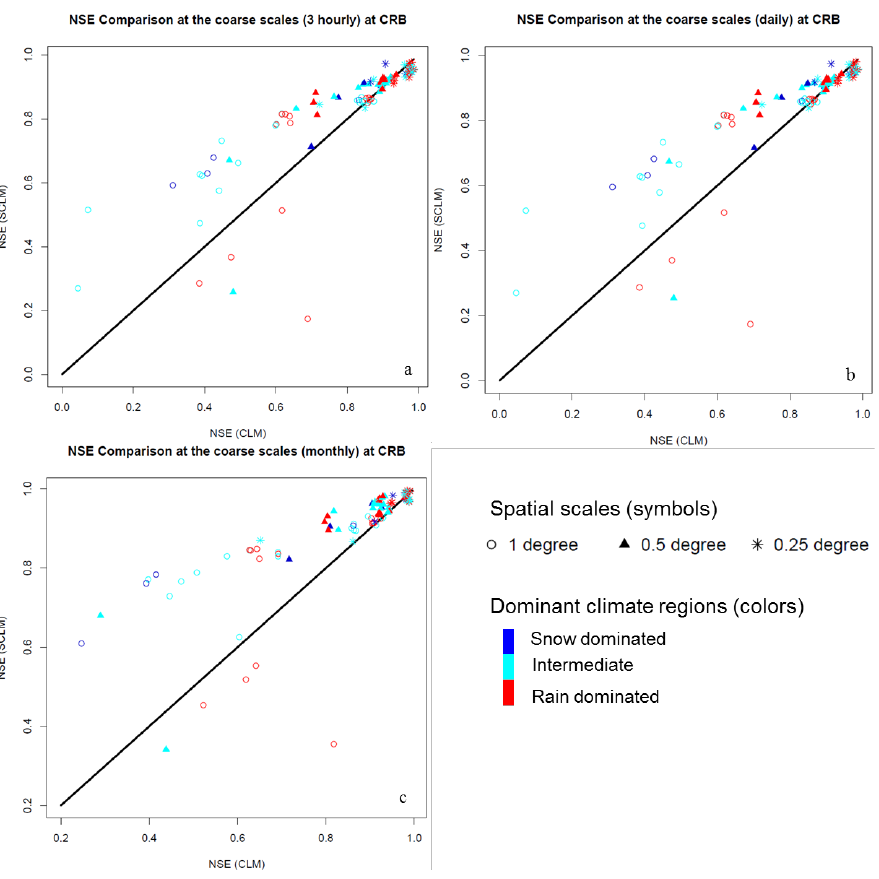
Figure 9. Scalability comparison using a NSE of streamflow at 3-hourly (a) , daily (b) and monthly (c) calculated between each coarse scale and the corresponding fine scale in each modeling framework at the USGS stations with contributing area larger than 15000km 2